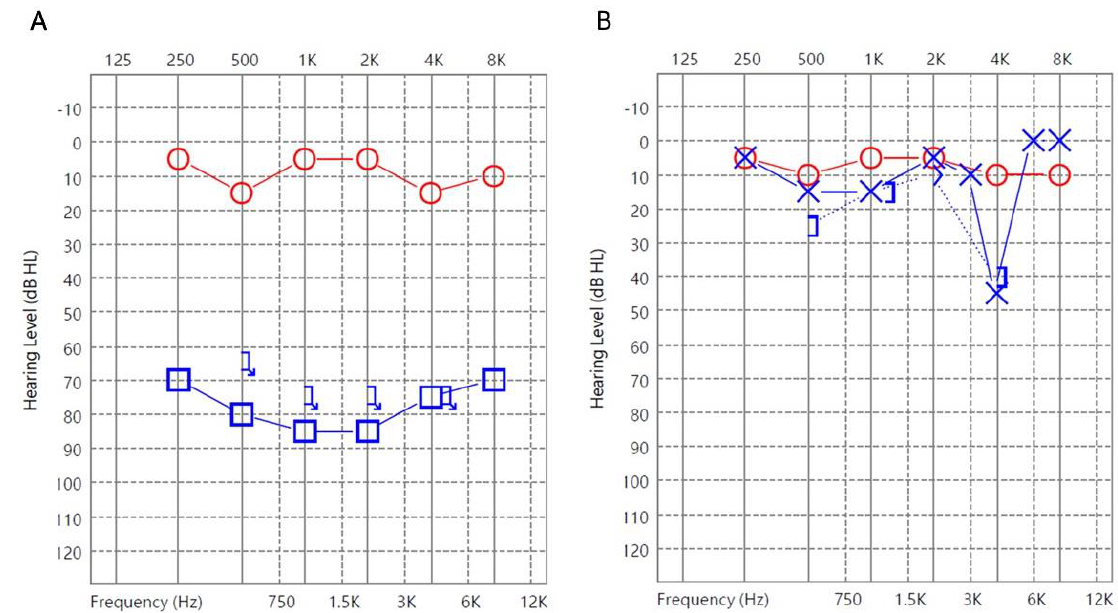
Figure 1. Audiograms of Patient 1 with positive PCR: ( A ) at presentation and ( B ) 2 months after treatment. (O: Unmasked air conduction thresholds in the right ear; X: Unmasked air conduction in the left ear; ]: Masked bone conduction in the left ear; ☐ : Masked air conduction in the left ear; Arrows (on any symbol): No response).